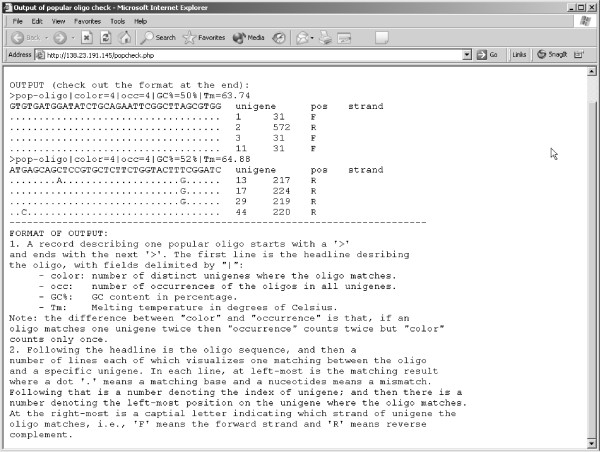
Screenshot of the web interface of OLIGOSPAWN for the oligo check.